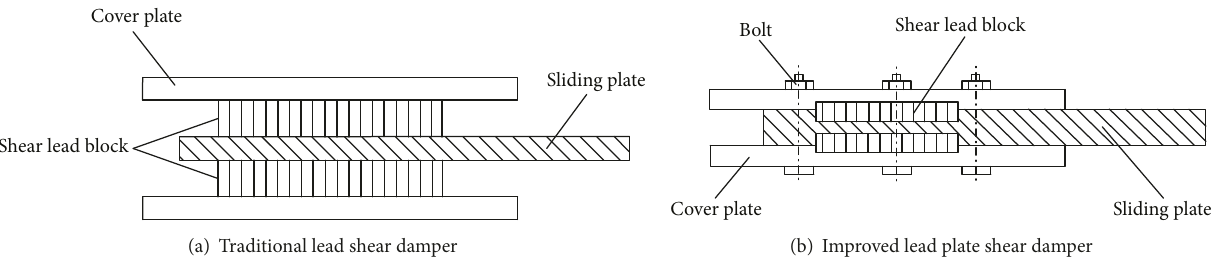
Figure 1: Ordinary plate lead shear